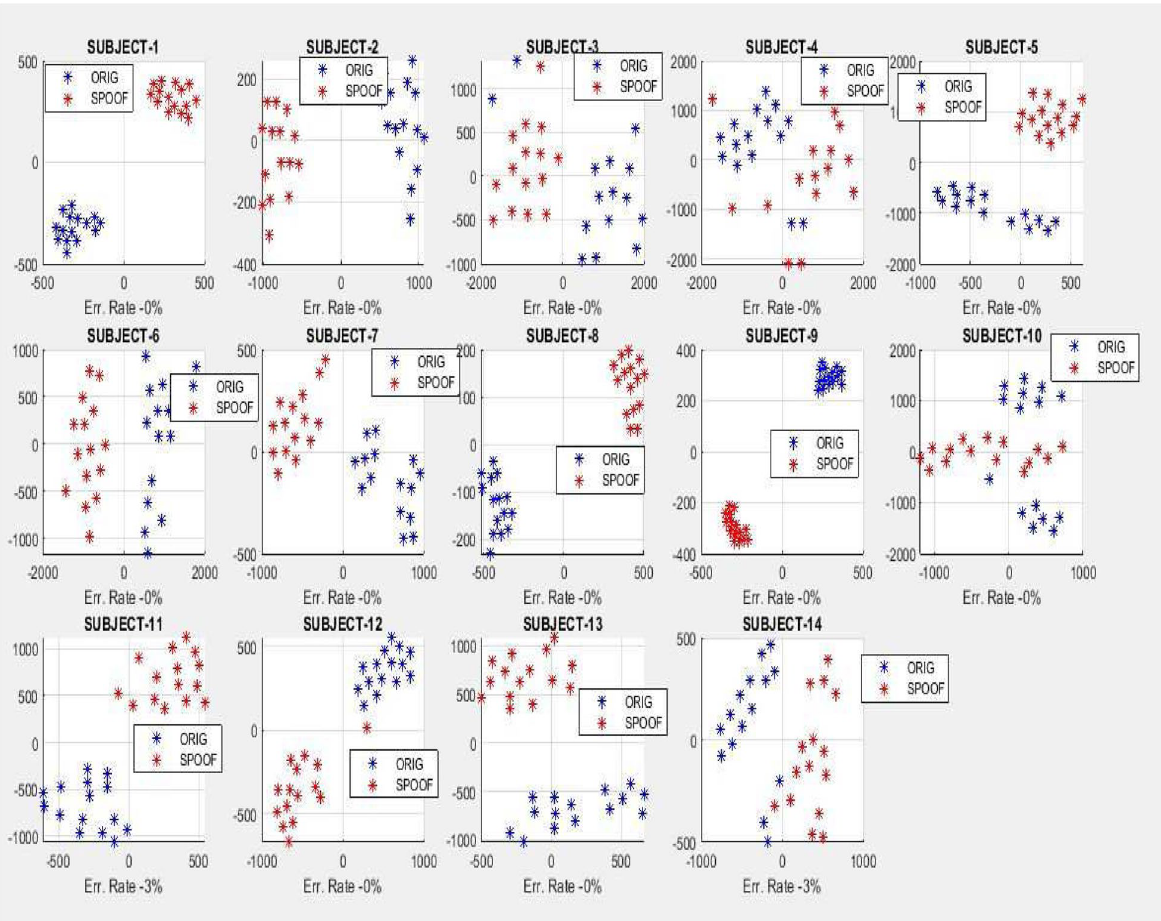
Fig. 13 Cluster separation (subject-wise) in a 2-class setting, for the reduced CASIA-dataset comprising of 14-subjects (out of a total of 50) in which 50% of the variations per subject, were used for testing